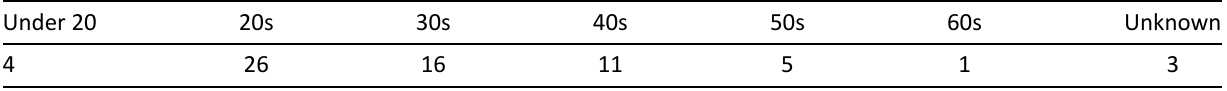
Table 2. Study 2: Age of participants in FGDs. Under